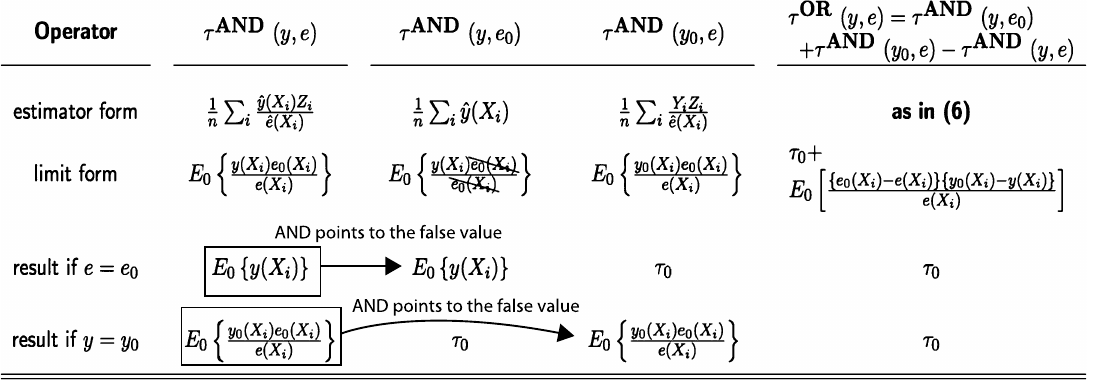
Figure 1: Generation of OR from AND operator, and falsifiability in the example of Section